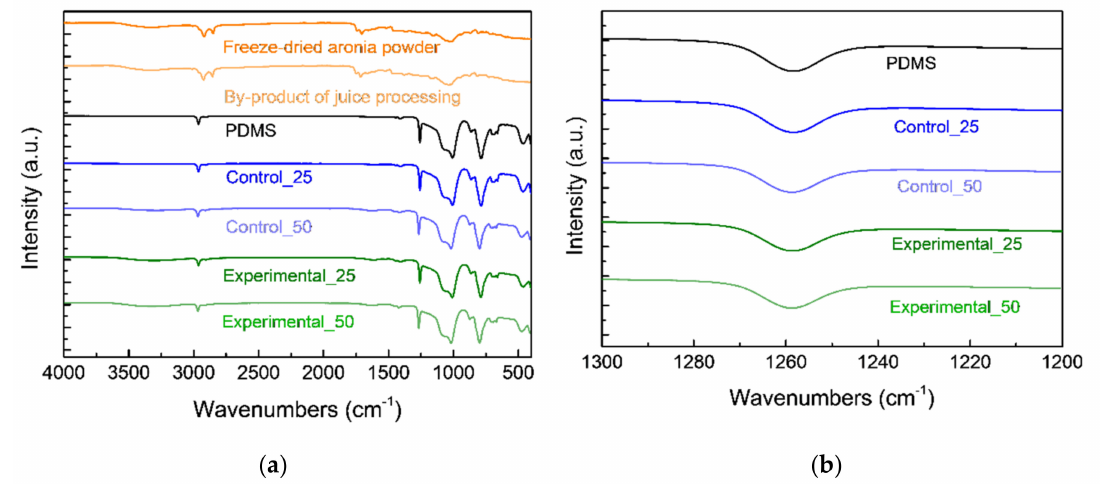
Figure 4. ( a ) Attenuated total reflectance–Fourier transform infrared spectroscopy (ATR-FTIR) spectra of aronia freeze-dried powder, aronia juice processing by-products, PDMS (0 wt%), Control_25, Control_50, Experimental_25, and Experimental_50; ( b ) details of Si–CH 3 bands of